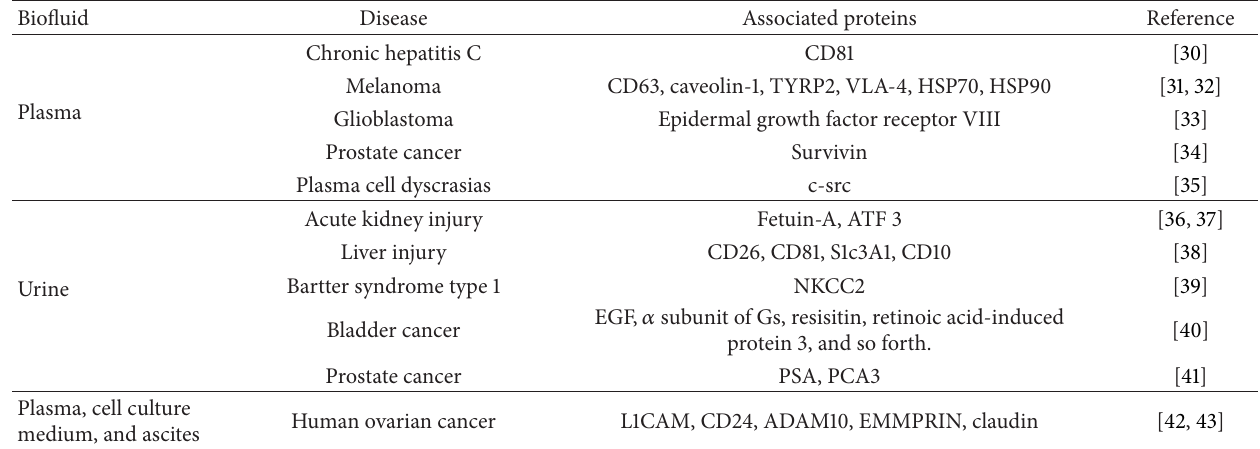
Table 1: Summary of exosomal proteins for clinical diagnostic